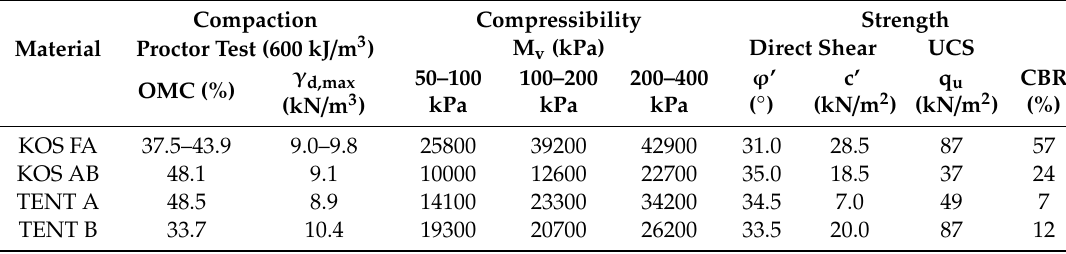
Table 6. Mechanical properties of tested materials without